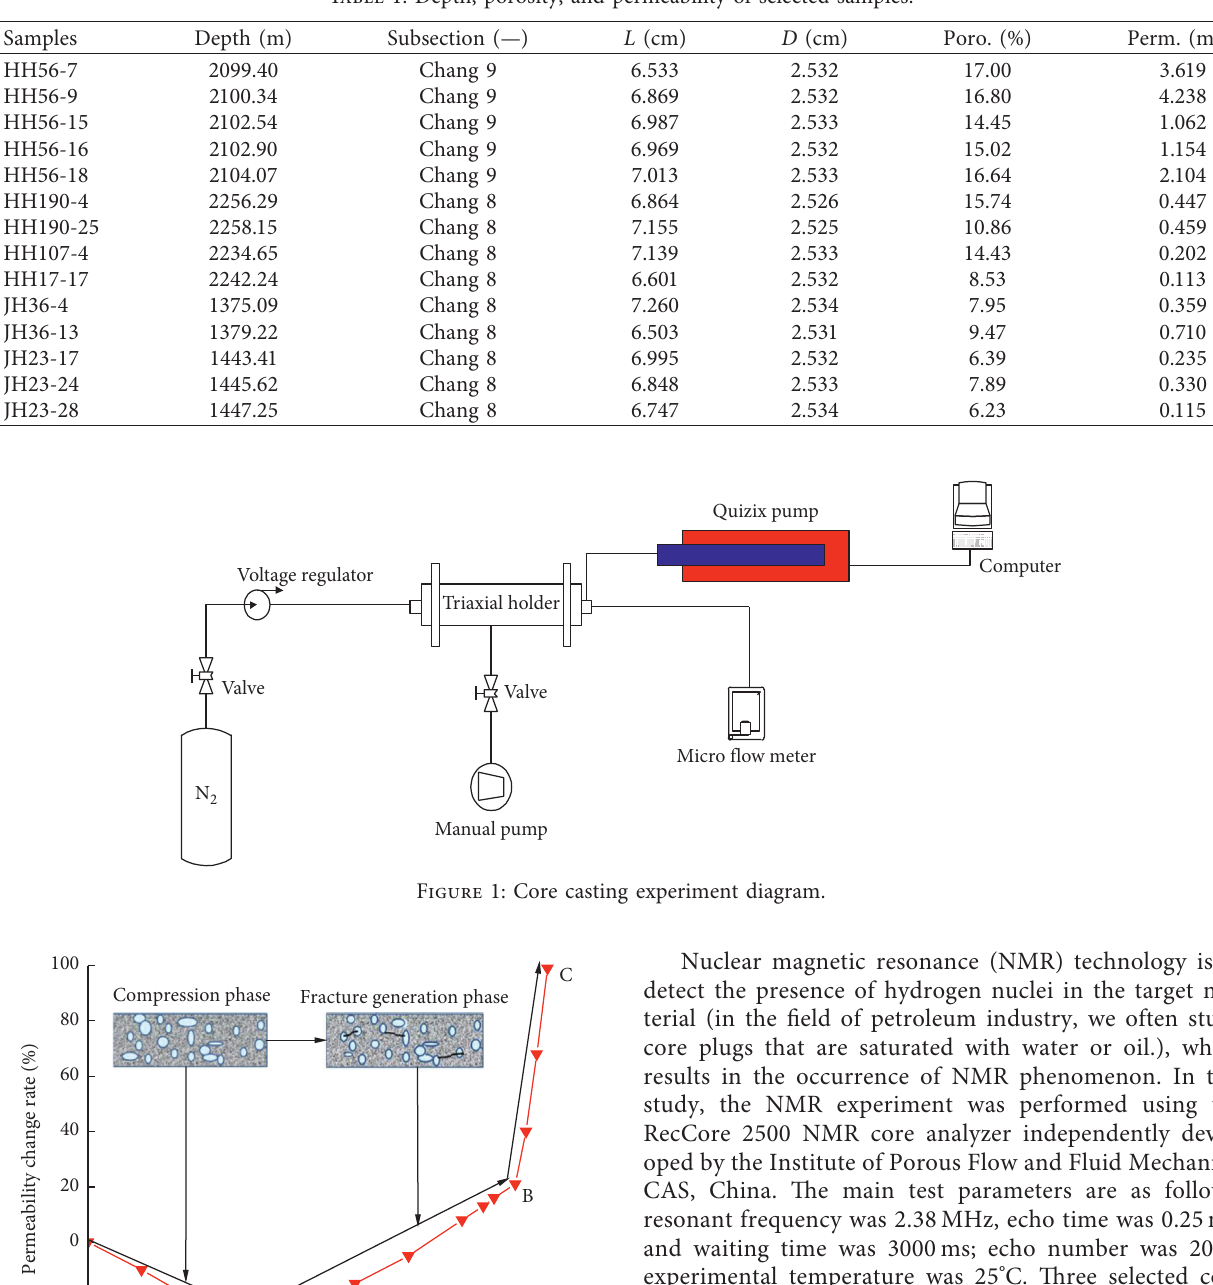
Table 1: Depth, porosity, and permeability of selected samples.